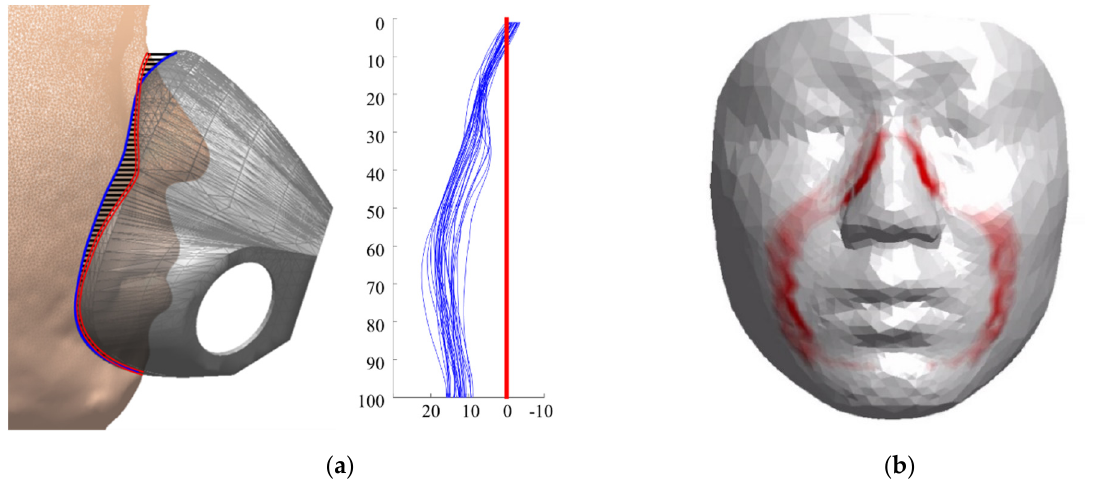
Figure 13. Finite element analysis for the estimation of contract pressure and deformation using the horizontal distance information identified by the proposed virtual fit analysis method (illustrated). ( a ) Virtual fit analysis result; ( b ) finite element analysis result.